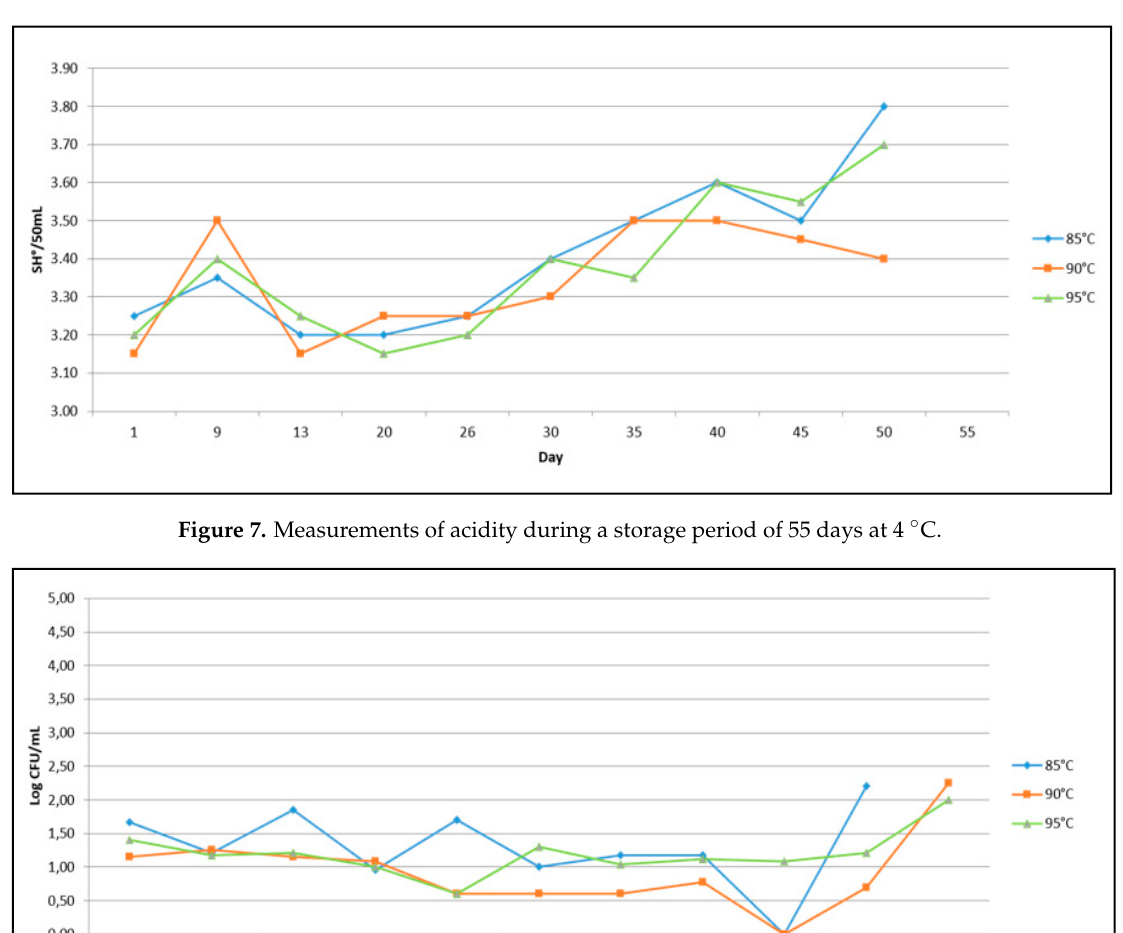
Figure 6. Measurements of pH during a storage period of 55 days at 4 °C.